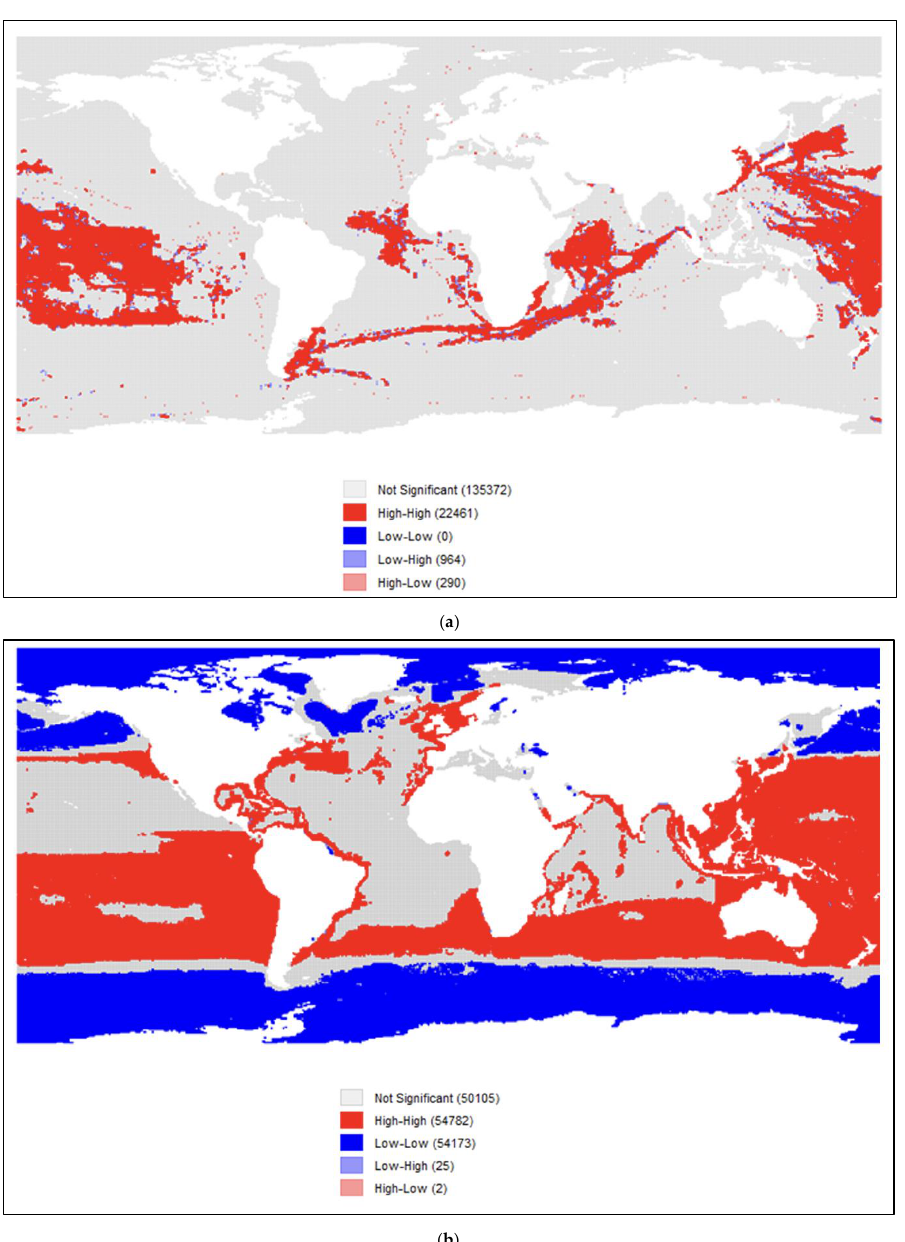
Figure 4. ( a ) A LISA cluster analysis of FOC longliners and ( b ) weighted CRAAVED fish presence. In ( a ) the LISA (local indicators of spatial autocorrelation) cluster map reveals a high positive auto- correlation (g lobal Moran’s I : 0.82; p < 0.001), whereby approximately 14% of grid cells (high – high) experienced FOC longliner presence and were surrounded by grid cells experiencing similar phe- nomena. FOC longliner presence is significantly concentrated in certain areas, and this is hypothe- sized to be related to areas where there is a higher cumulative weighted risk of fish being CRAAVED. In ( b ), findings show a high positive autocorrelation (g lobal Moran’s I : 0.98; p < 0.001), whereby approximately 34% of at-sea grid cells (high – high) experienced statistically significant clusters of CRAAVED fish presence. Comparing ( a , b ) with each other, it can be seen that FOC pres- ence hot spots tend to overlap in CRAAVED fish hot spots, particularly in the Pacific Ocean near South America, Asia, Oceania, in the southern Atlantic Ocean, and in the Indian Ocean ( r = 0.38; p < 0.001). Tables 1 and 2 provide descriptive statistics of the study variables and the results of the OLS regression model. According to Table 2, the overall results indicate that the vari- ables collectively statistically significantly explain the average risk scores for albatrosses (F (5, 159,086) = 12,662 p < 0.01; R 2 = 0.285). All the variables added statistically significantly to the model ( p < 0.01). The average risk score of albatrosses is significantly higher in the areas where FOC-flagged or potentially illegal longline vessels are found. The average risk score of albatrosses is significantly lower in the areas where other longlining activity takes place. The cumulative risk score of CRAAVED fish species (i.e., their presence and risk of IUU fishing) can significantly explain the average risk score of albatrosses. In other words, the highest risk areas for CRAAVED fish species overlap with highest risk areas of albatrosses. The independent variable with the strongest beta value is the cumulative risk score of CRAAVED fish, followed by the presence of FOC-flagged longline vessels and the presence of legal longline vessels.